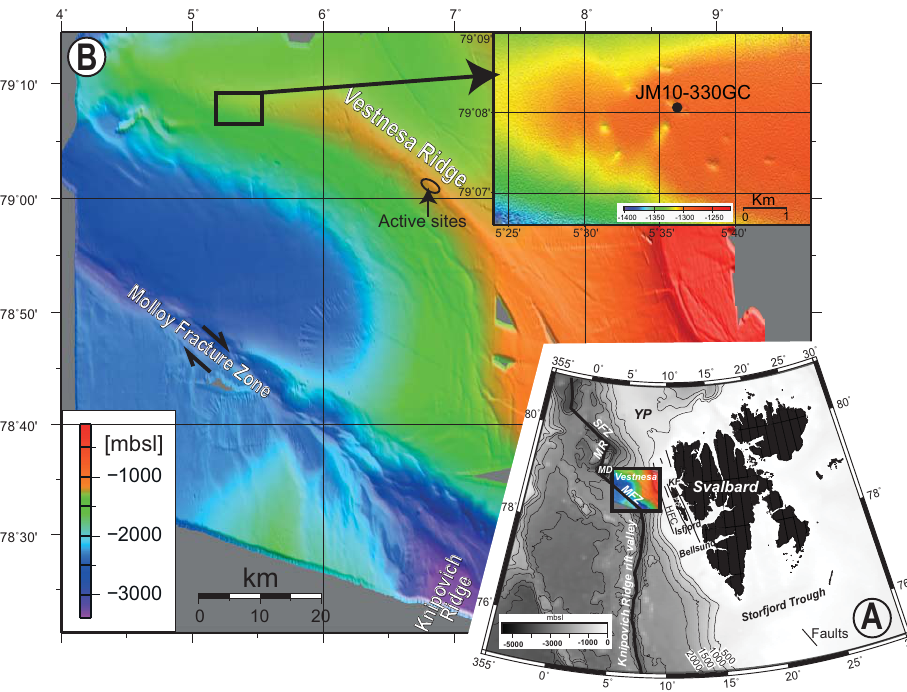
Figure 2. (a) Western Svalbard margin and eastern Fram Strait. Abbreviations: MFZ, Molloy Fracture Zone; MD, Molloy Deep; MR, Molloy Ridge; SFZ, Spitsbergen Fracture Zone; YP, Yermak Plateau. (b) Overview swath bathymetry map of the Vestnesa Ridge. Locations of studied core JM10-330GC and location of active sites with gas flares observed in June 2010 (Bünz et al., 2012) and in 2012 (Smith et al., 2014) are indicated. Figures are modified after Hustoft et al.